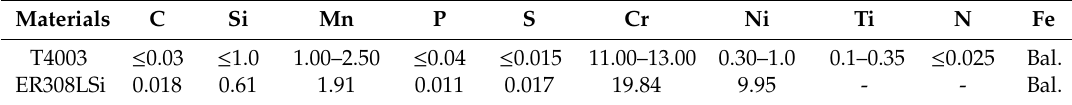
Table 1. The chemical composition of T4003 ferritic stainless steel and ER308LSi welding wire (wt.%). Materials C